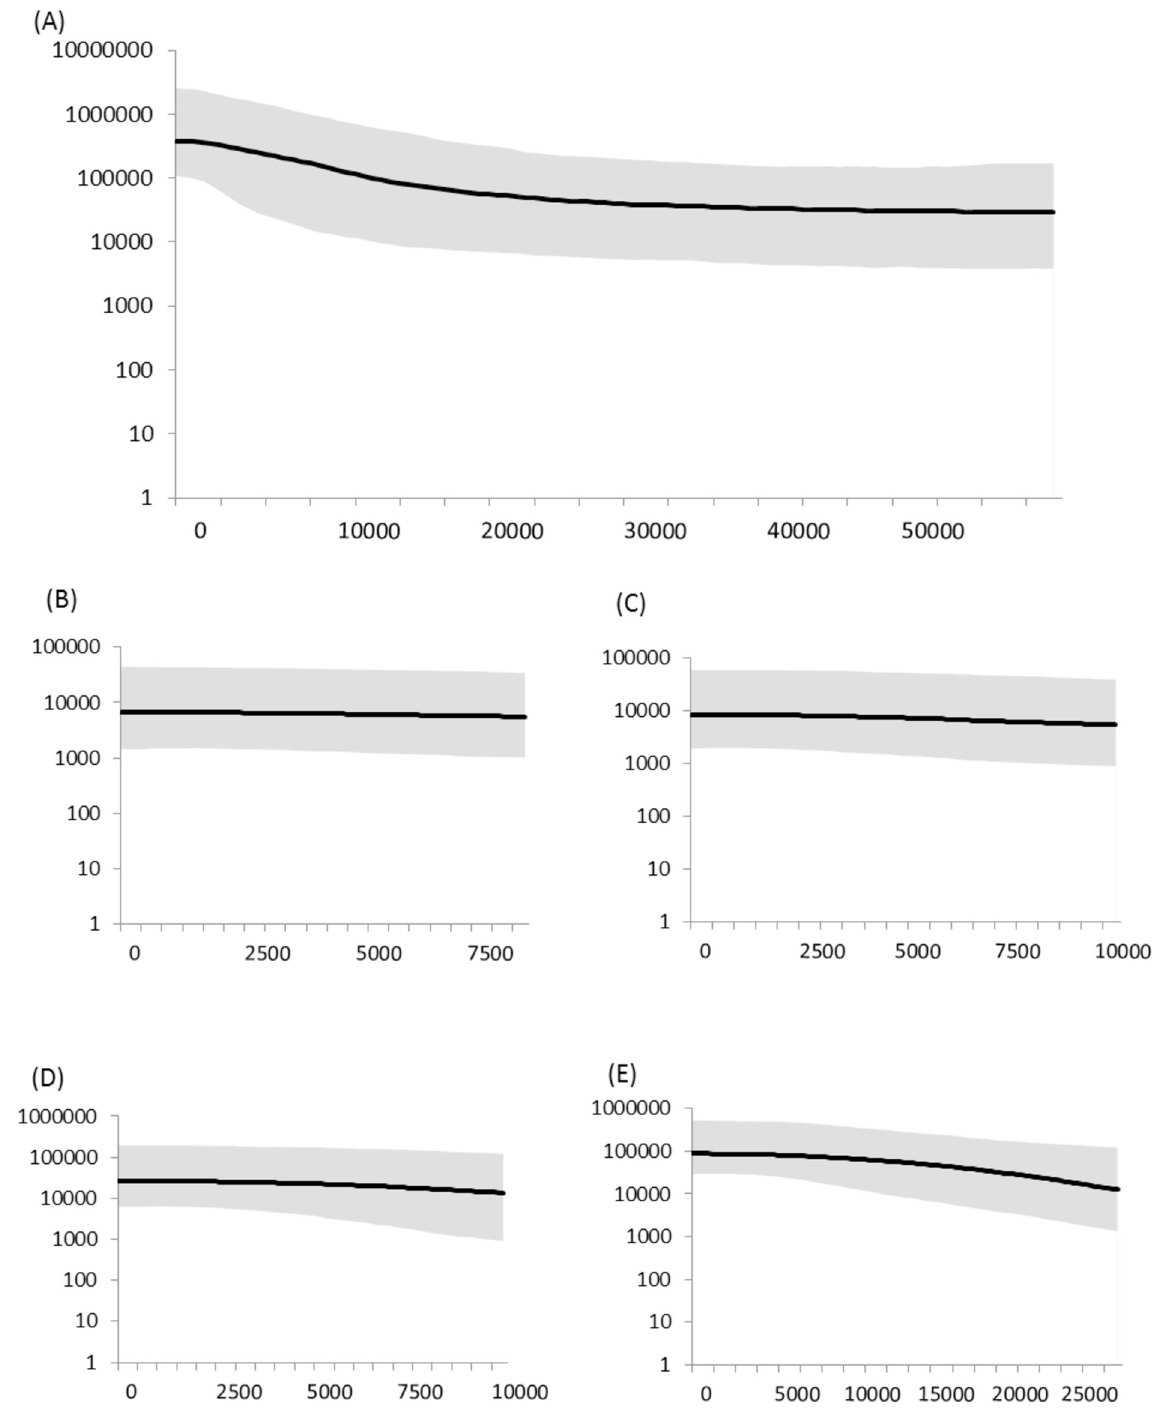
Fig 5. Bayesian skyline plots of the effective population size over time for the koala. (A) overall, (B) northern lineage 1 (C) northern lineage 2, (D) central lineage and (E) southern lineage. Median estimates are shown as solid lines and shading represents the 95% highest posterior density